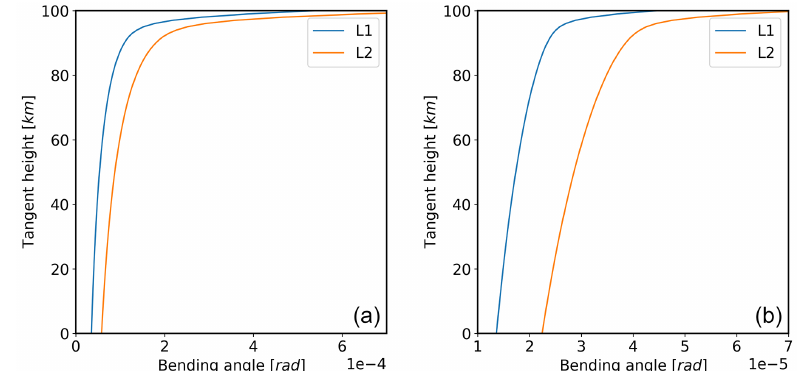
Figure 3. L1 and L2 bending angles for test 1 ( a , midday) and test 2 ( b , midnight).